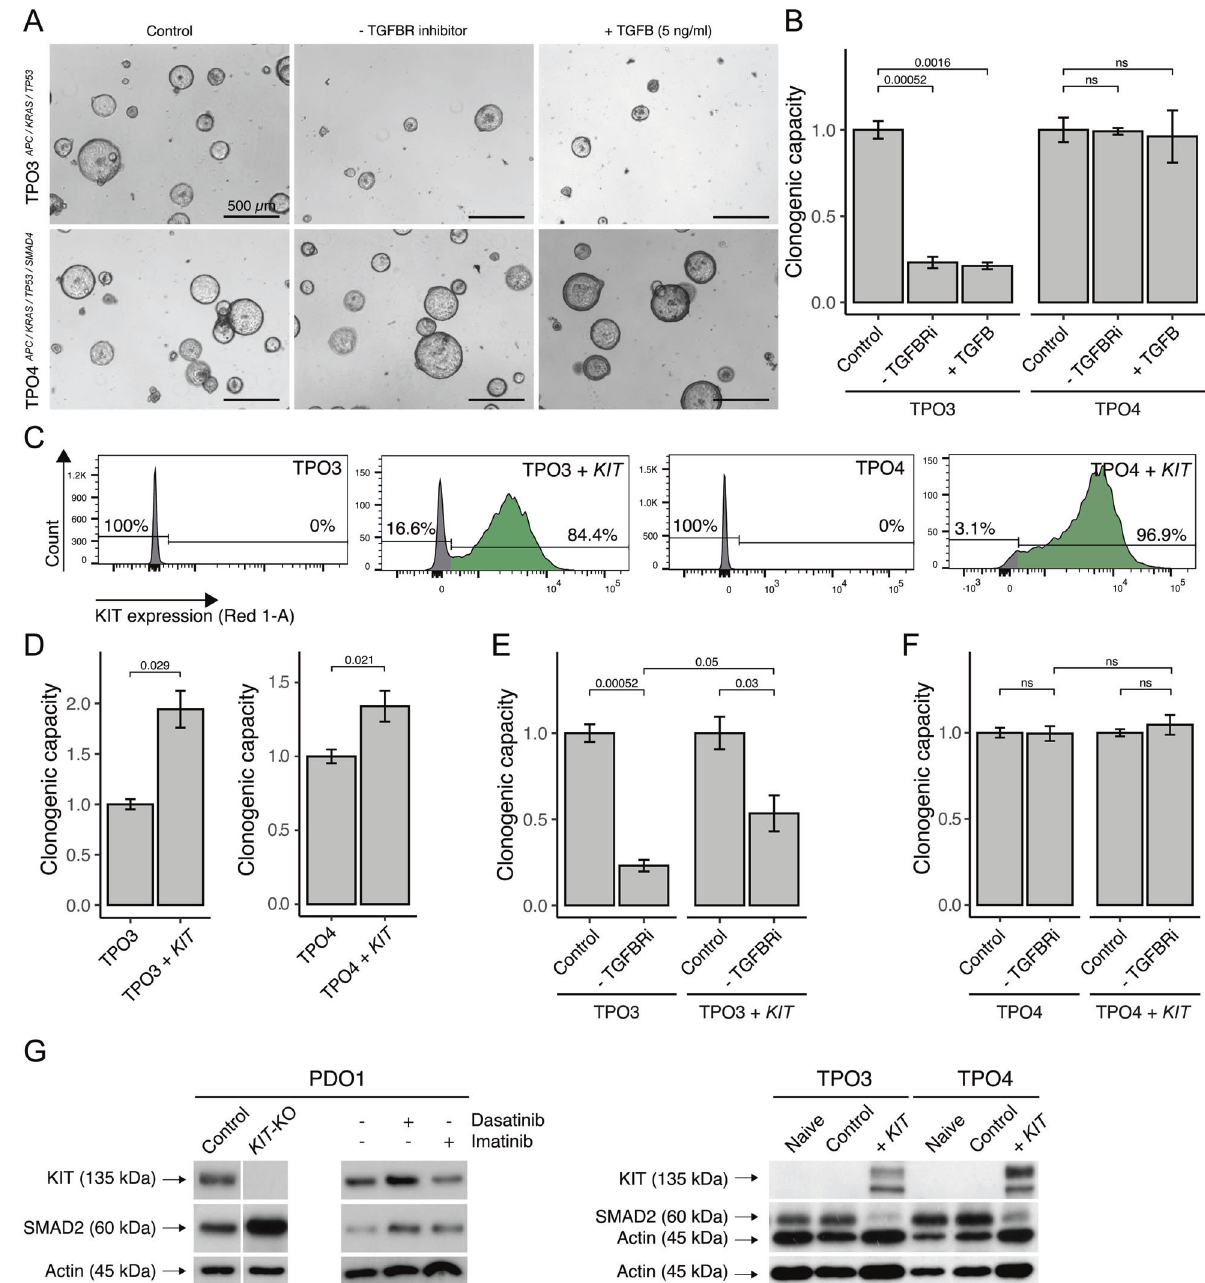
Fig. 6 KIT expression partially substitutes for SMAD4 mutation in tumor progression organoids. A Bright fi eld images of TPO3 and TPO4 organoids in normal CRC culture medium, A83-01 depleted medium, and/or TGFB-stimulated medium (5 ng/ml). Scale bar is 500 µm. B Regenerative capacity assay of ( A ). C Flow-cytometry analysis demonstrating presence of KIT in TPO3 KIT and TPO4 KIT , generated with lentiviral overexpressing vector. D KIT increases the regenerative capacity in TPO3 KIT and TPO4 KIT , at least two experiment with three technical replicates in each. E Regenerative capacity assay for TPO3 CONTROL , TPO3 KIT , F TPO4 CONTROL , and TPO4 KIT in normal CRC culture medium and A83-01 depleted medium, at least two experiment with three technical replicates in each. G Western blot demonstrating reduced total SMAD2 protein in organoids with KIT expression. Dasatinib 100 nM and Imatinib 5 µM. An unpaired t-test was applied to assess the signi fi cance between the spontaneous metastasis mouse model, pharmacological blockade of TGF β stromal signaling prevented metastasis initiation [36]. These data indicate that TGF β in the tumor microenvironment induces a pro-metastatic program. Our data show that KIT expression causes a phenotypic shift from CMS2 to CMS4 generating tumors with increased stromal content and high expression of TGF β .